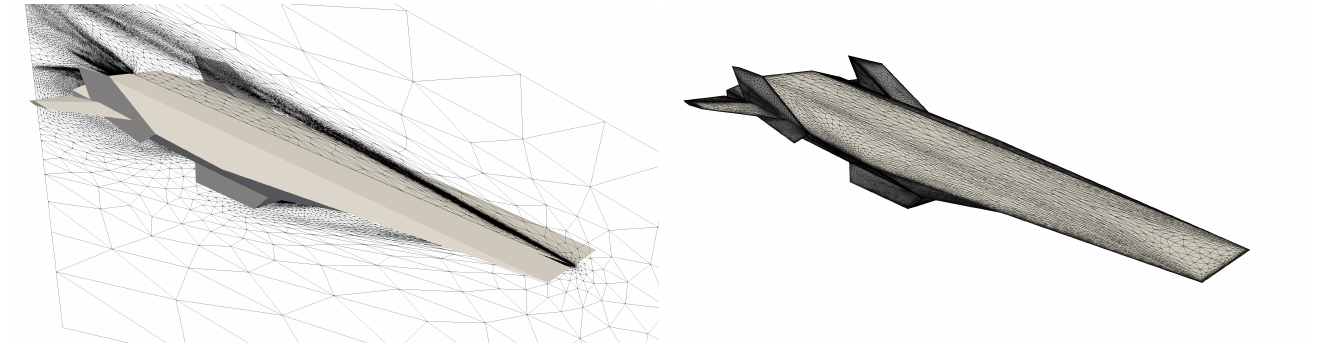
Figure 18. X43a volume and surface